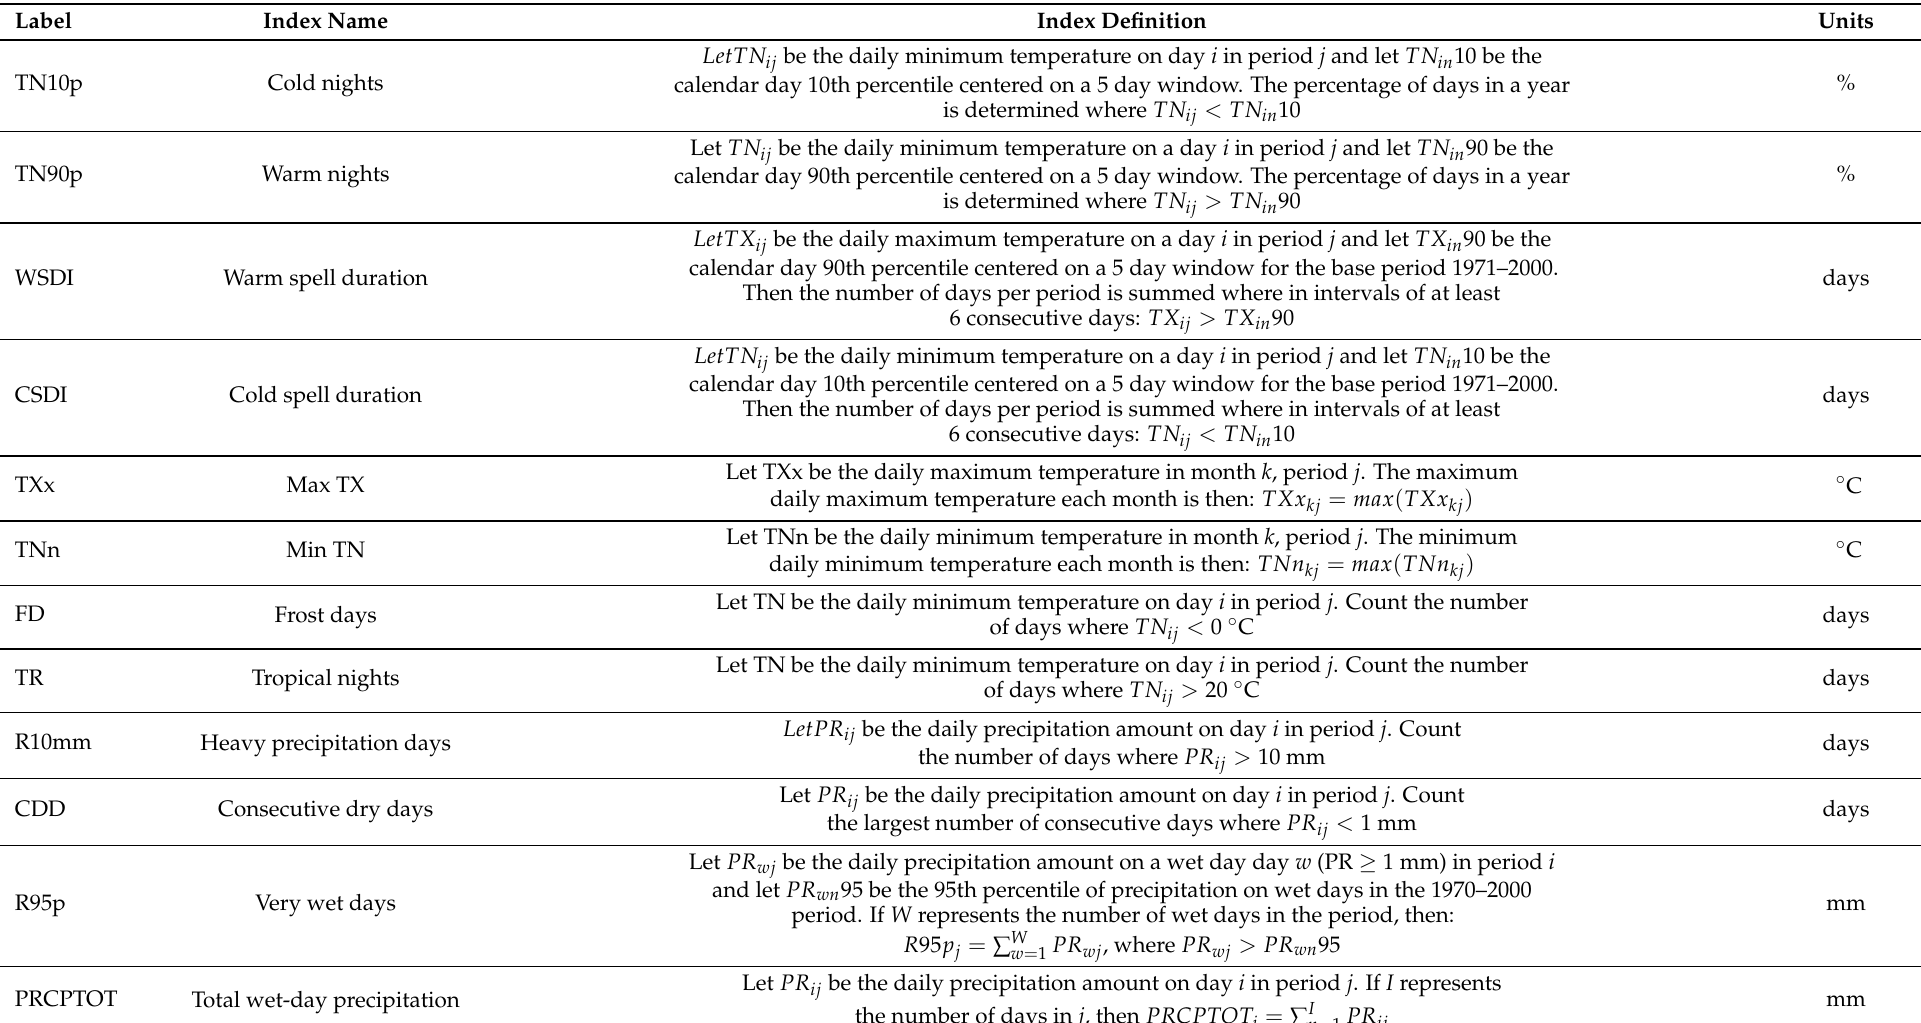
Table 1. A subset of the climate extreme event indices recommended by the ETCCDI that are used in this study. Adopted from the work of Sillmann et al.